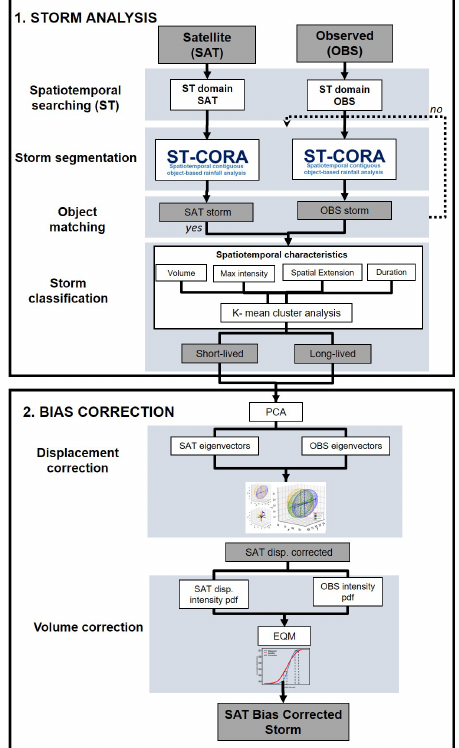
Figure 2. Diagram of the Spatiotemporal Contiguous Object-based Rainfall Analysis for bias correction (ST-CORAbico) method. Grey boxes represent the input and output products while white boxes describe the methodological process for storm analysis and bias correction